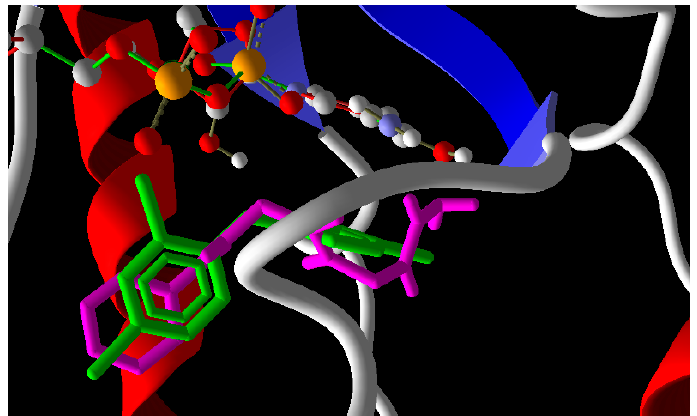
Figure 3. Overlay of Compound 4 (purple) and triclosan (green) in the groove of enoyl reductase (Red: alpha helix Blue: Beta sheets).